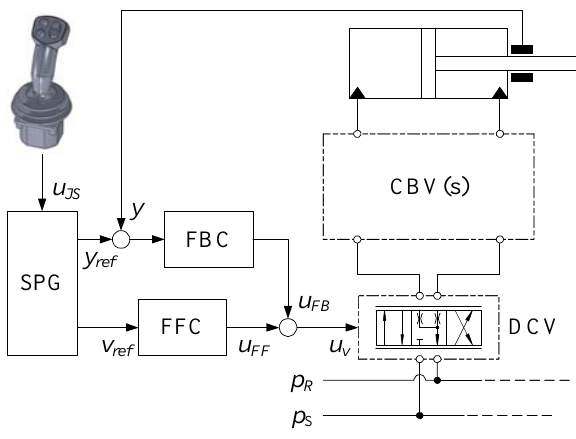
Figure 1: Simplified schematic of electro-hydraulic mo- tion control